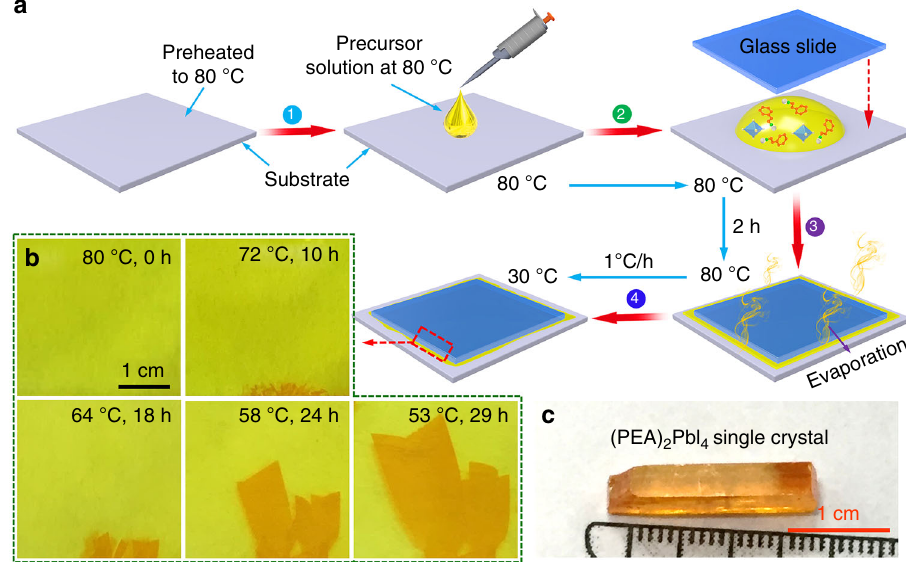
Fig. 2 IPC growth process of (PEA) 2 PbI 4 SCM. a Schematic illustration of the IPC procedure to grow 2D layered (PEA) 2 PbI 4 SCM. b Photos of a (PEA) 2 PbI 4 SCM taken at different stages of the growth process. c Photo of a typical (PEA) 2 PbI 4 crystal.